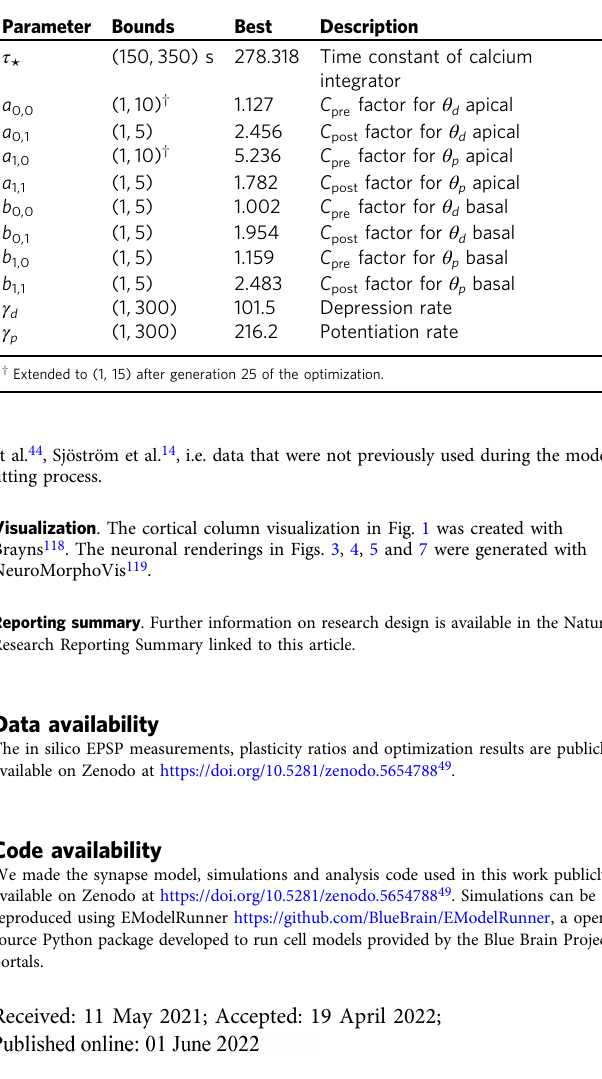
Table 2 Optimized parameters with respective boundaries and best solution for the long term plasticity